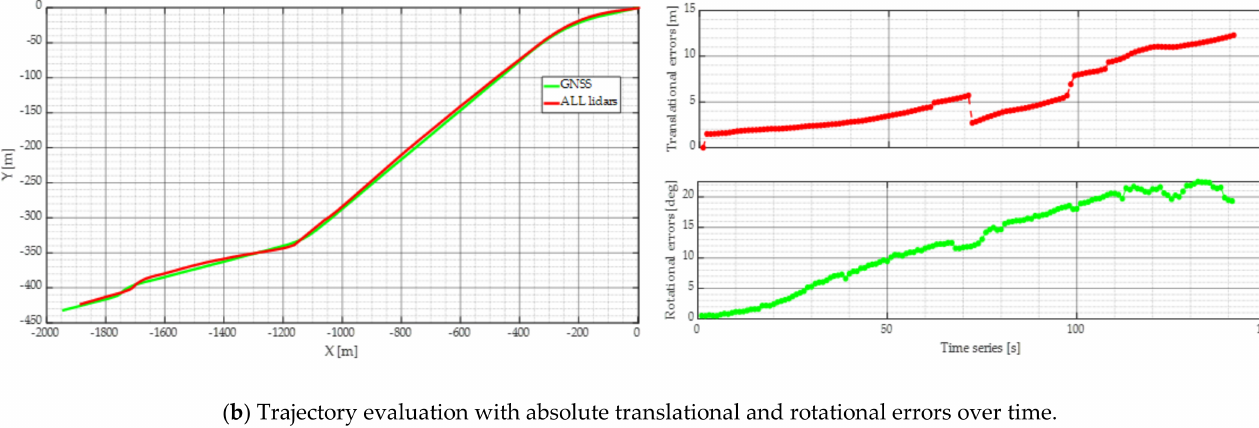
Figure 11. Mapping and odometry results of experiment #2.